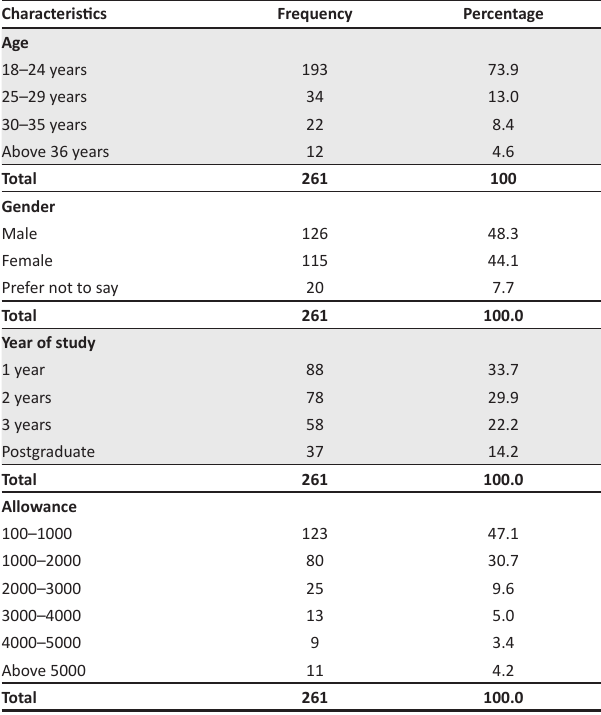
TABLE 1: Sample demographic characteristics